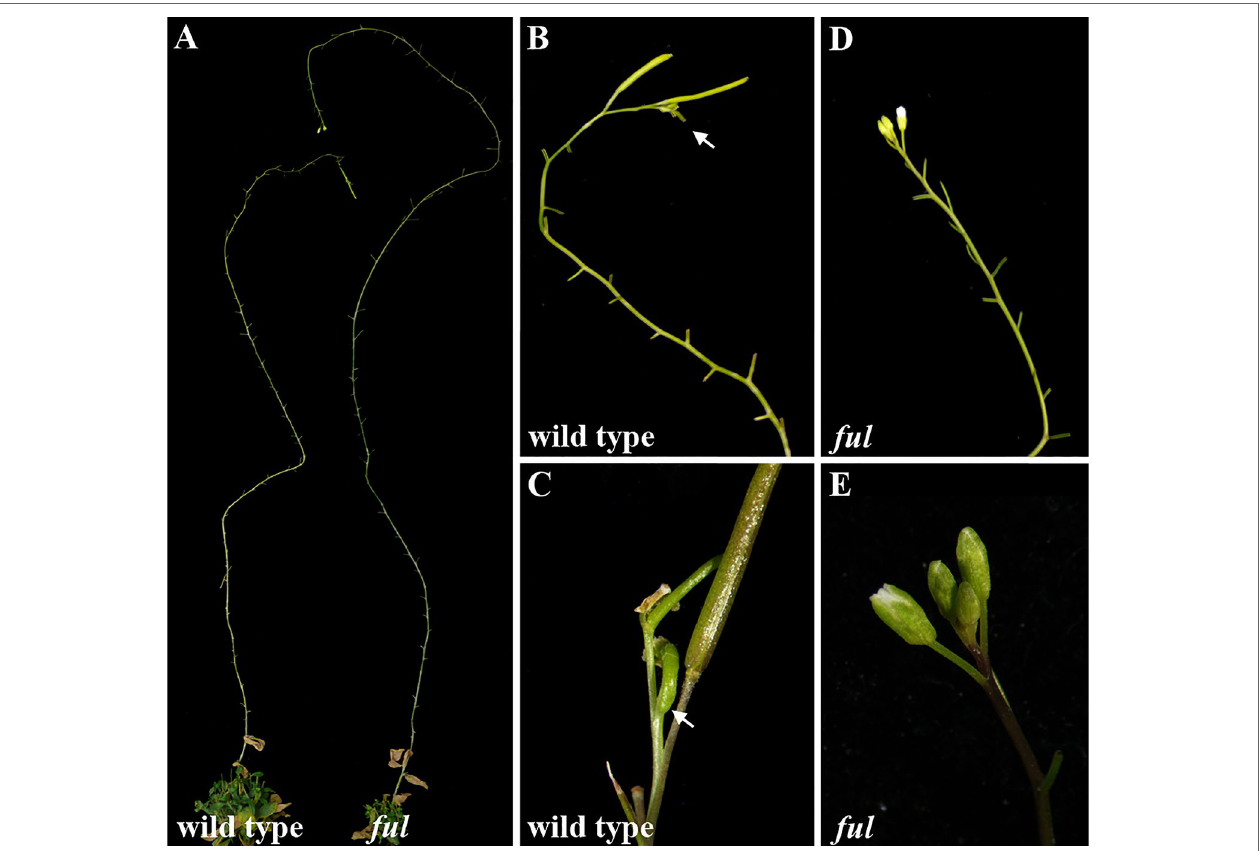
FIgURe 1 | Inflorescence phenotype of pruned 14-week-old plants. All branches, as well as flowers in anthesis stage were removed in wild type and ful mutant plants (a) . Plants stay alive for longer, delaying the end of flowering. At the end of the flowering phase, wild type inflorescence becomes determinate (B , c) , producing a terminal flower (arrow) while ful mutant remains indeterminate (D , e) .